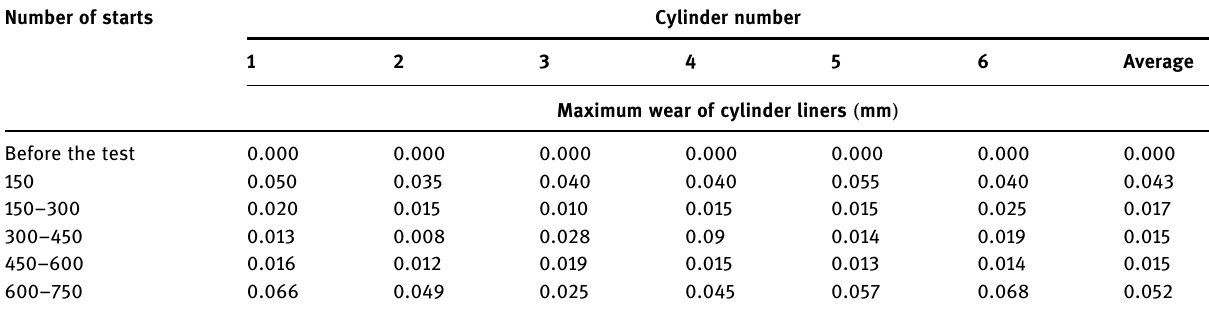
Number of starts